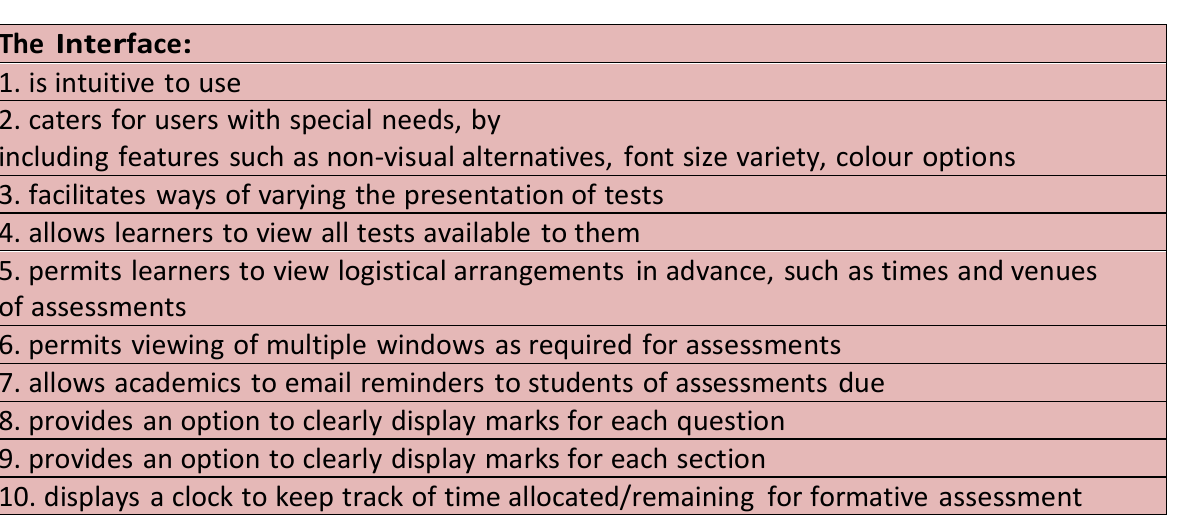
e-SEAT ’ s Non-Functional